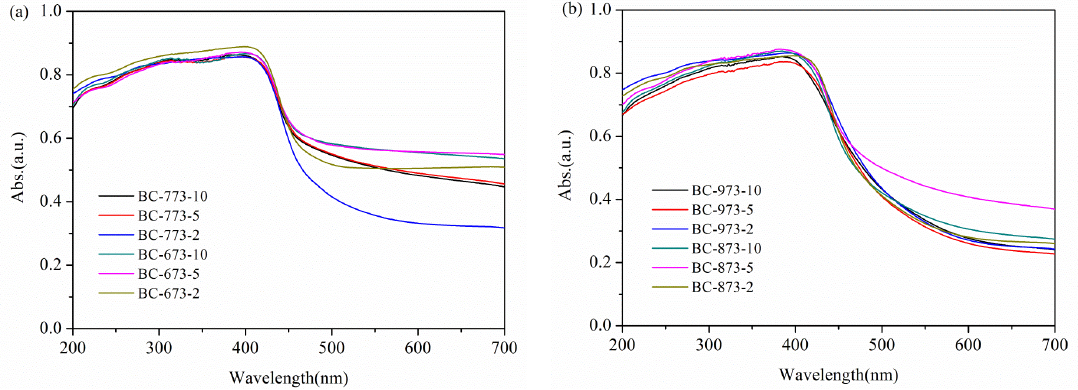
Figure 6. UV ‐ Vis diffuse reflectance spectra of the as ‐ prepared coatings: ( a ) BC ‐ 673 ‐ 2, BC ‐ 673 ‐ 5, Figure 6. UV-Vis diffuse reflectance spectra of the as-prepared coatings: ( a ) BC-673-2, BC-673-5, BC-673-10, BC ‐ 673 ‐ 10, BC ‐ 773 ‐ 2, BC ‐ 773 ‐ 5, BC ‐ 773 ‐ 10; ( b ) BC ‐ 873 ‐ 2, BC ‐ 873 ‐ 5, BC ‐ 873 ‐ 10, BC ‐ 973 ‐ 2, BC ‐ 973 ‐ 5, BC-773-2, BC-773-5, BC-773-10; ( b ) BC-873-2, BC-873-5, BC-873-10, BC-973-2, BC-973-5, BC ‐ 973 ‐ 10.